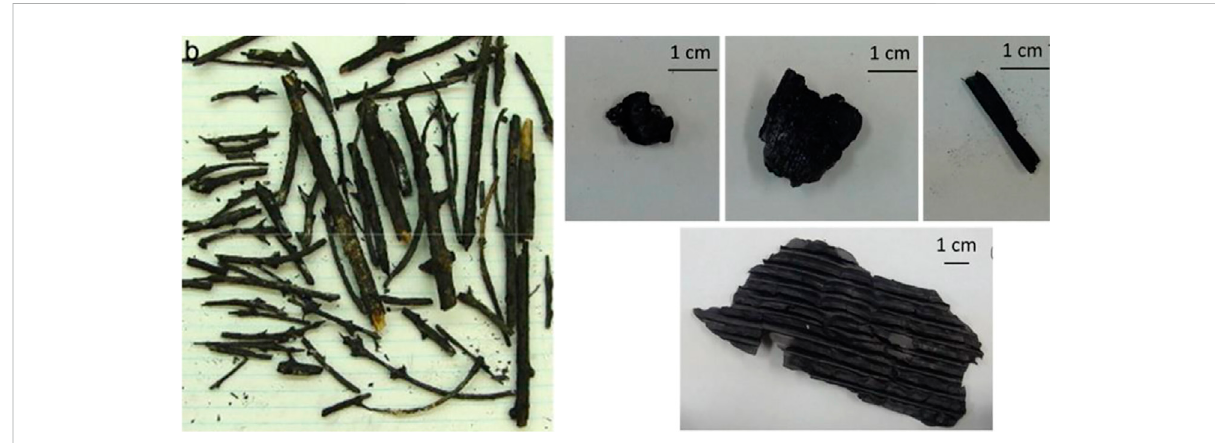
FIGURE 5 Examplesof fi rebrandscollectedfromvegetativefuelcombustionasopposedtostructuralfuelcombustion(Suzuki,2019).Left: fi rebrandsfrom